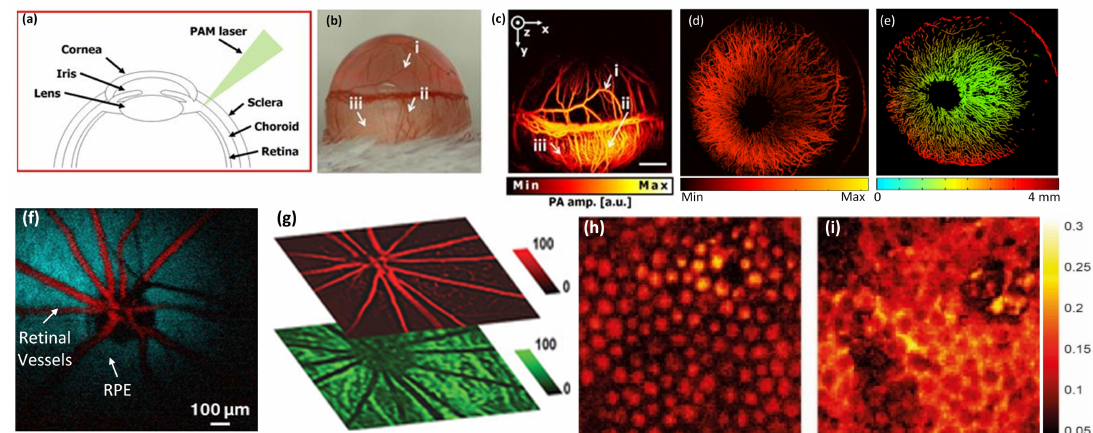
Figure 6. Photoacoustic microscopy of the retinal: ( a ) structure of mouse eye, ( b ) a photograph of the mouse eye, ( c ) corresponding MIP PAM image of the corneal microvasculature in an albino mouse eye in ( b ), showing the iris, and limbal blood vessels as well as the retinal and choroidal vessels underlying the sclera [51]. ( d ) Photoacoustic microscopy of the iris vasculature of rat. ( e ) Depth-encoded PAM image [83]. ( f ) Pseudo-colored PAOM images of the retinal vessels and RPE [33]. ( g ) Segmented PAOM of the retinal and choroidal blood vessels. The retinal vessels are pseudo-colored in red, and the choroidal vasculatures are pseudo-colored in green [58]. ( h , i ) segmented PAM porcine retinal pigment endothelium (RPE) and choroid [84]. Adapted with permission from ref [33,51,83,84].